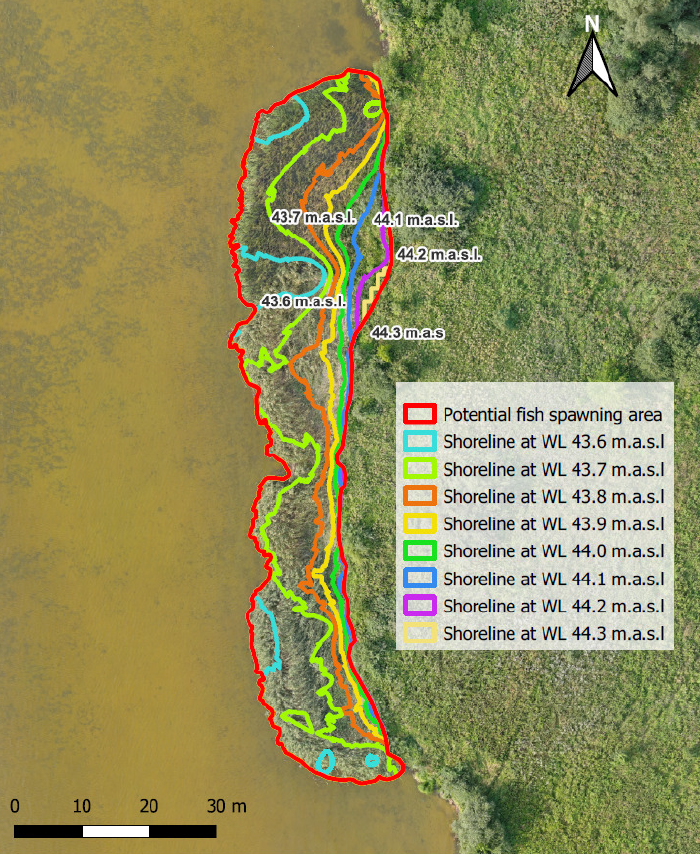
Figure 5. Shoreline changes in the potential fish spawning site during water level drawdowns in the reservoir.